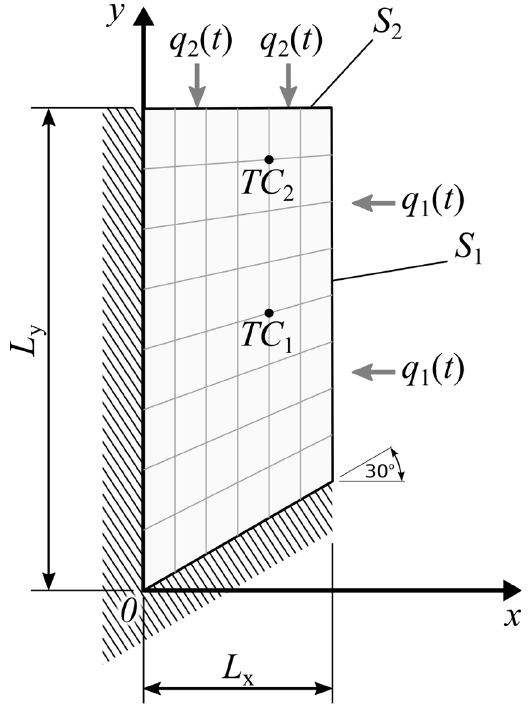
Figure 14. Deformed plate with boundary conditions and measuring points.